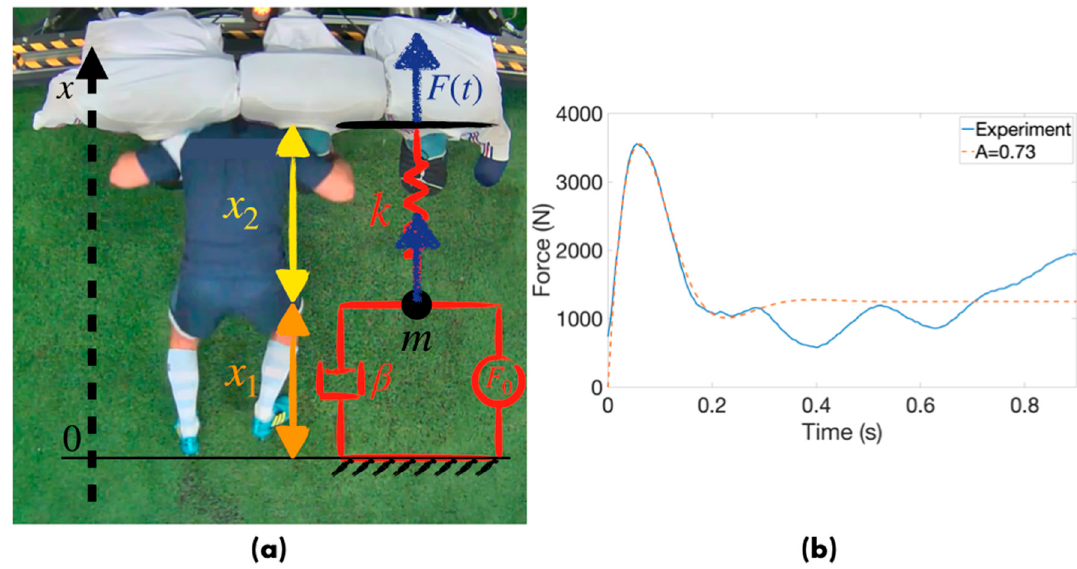
Figure 3. MacMahon look alike model of a single player against a scrum machine. ( a ) We introduce the system at the impact time 𝑡 (cid:2868) with 𝑚,𝑘,𝛽, 𝐹 (cid:2868) defined in the main text. The force measured by the scrum machine is called 𝐹 . ( b ) Compression force time evolution. Comparison between the hooker’s experimental curve and the fitting results curve with parameters detailed in the text.